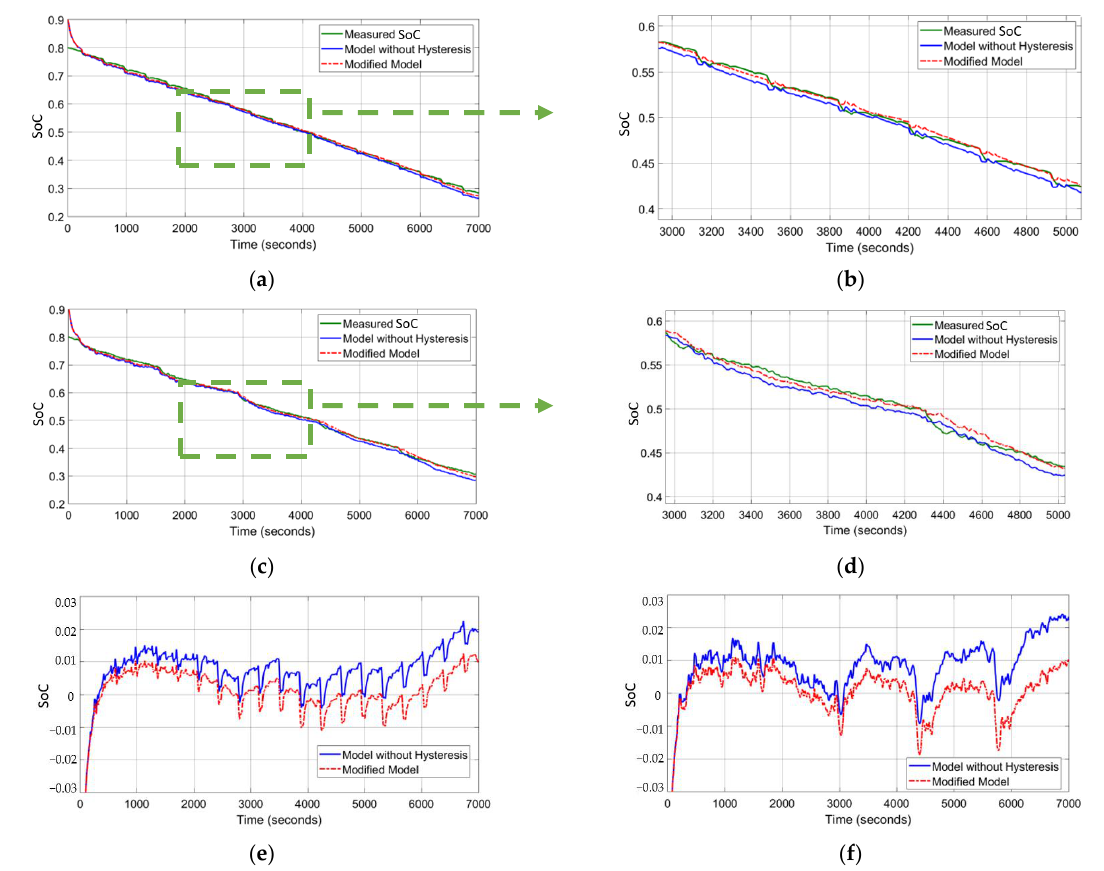
Figure 4. Battery SoC estimation results using TSMO: ( a ) SoC estimation results using DST; ( b ) enlarged simulated result of ( a ) between 3000 s – 5000 s; ( c ) SoC estimation results using FUDS; ( d ) ( b ) enlarged simulated result of ( a ) between 3000 s–5000 s; ( c ) SoC estimation results using FUDS; enlarged simulation result of ( c ) between 3000 s – 5000 s; ( e ) SoC estimation error under DST; and ( d ) enlarged simulation result of ( c ) between 3000 s–5000 s; ( e ) SoC estimation error under DST; and ( f ) SoC estimation error under FUDS. ( f ) SoC estimation error under